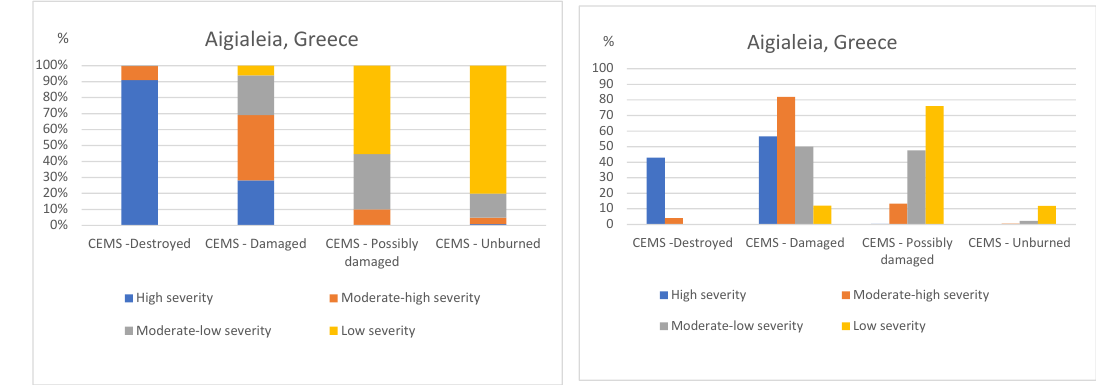
Figure 8. Contribution of the fire impact severity class as identified by the proposed approach for the identification of the relevant CEMS class ( left ), and relevance of the categorization of the proposed approach in relation to the definition merging by CEMS ( right ).